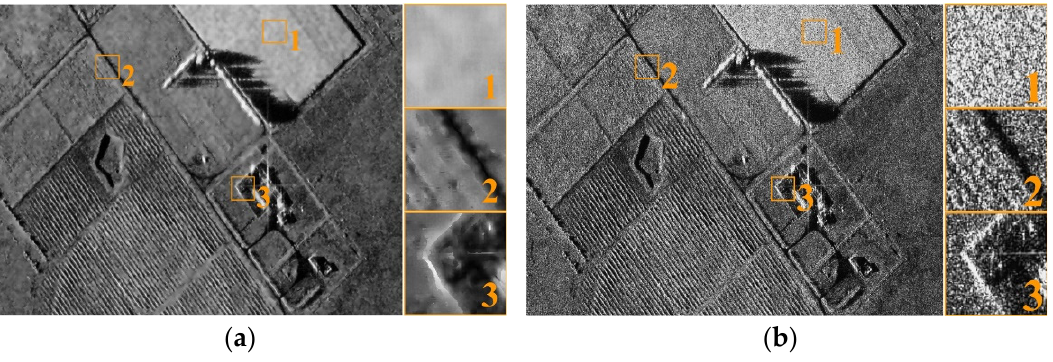
Figure 21. Comparison of the de-speckling results between the proposed method and the DnCNN method: ( a , b ) are filtering results of our method and the DnCNN method, respectively.